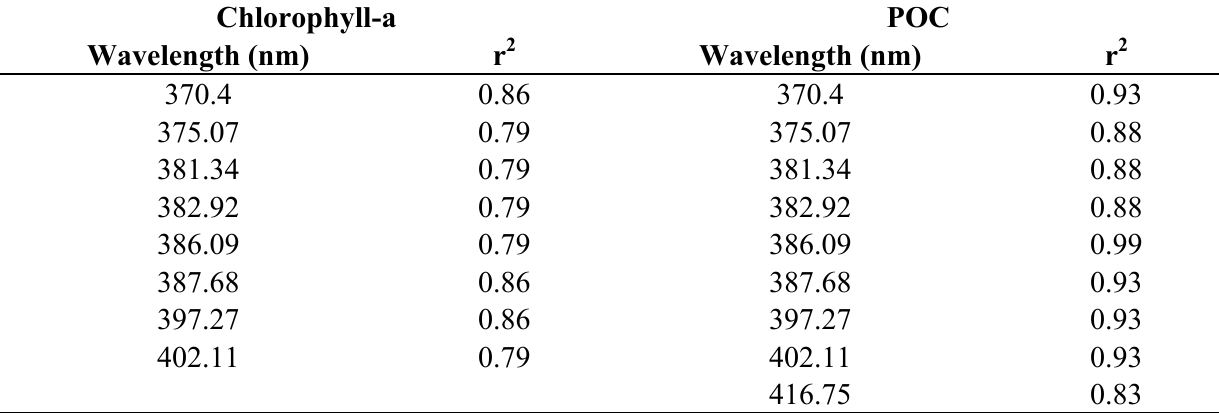
Table 2. Highest correlations (expressed as r 2 ) achieved when applying regressions to chlorophyll-a and POC against the GER1500 reflectance values.